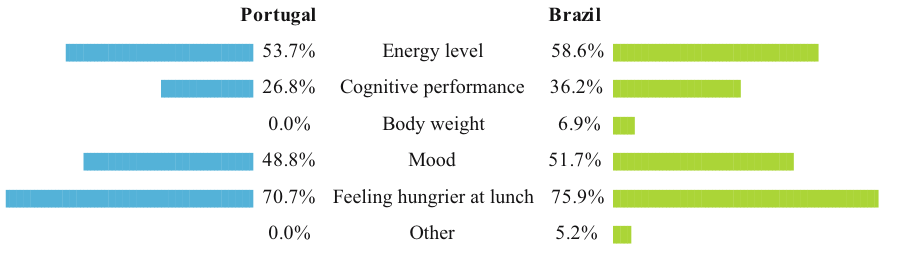
Figure 5: Di ff erences observed when skipping breakfast.